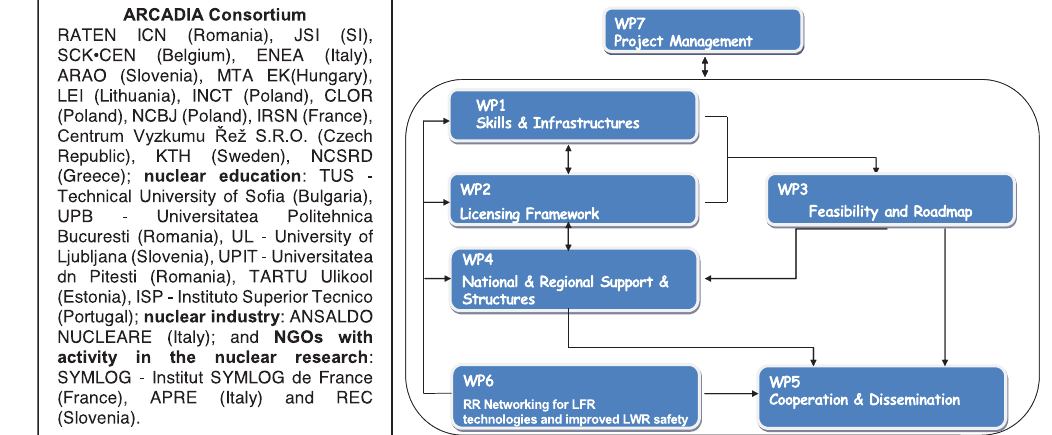
Fig. 2. Consortium composition and functional sketch of the